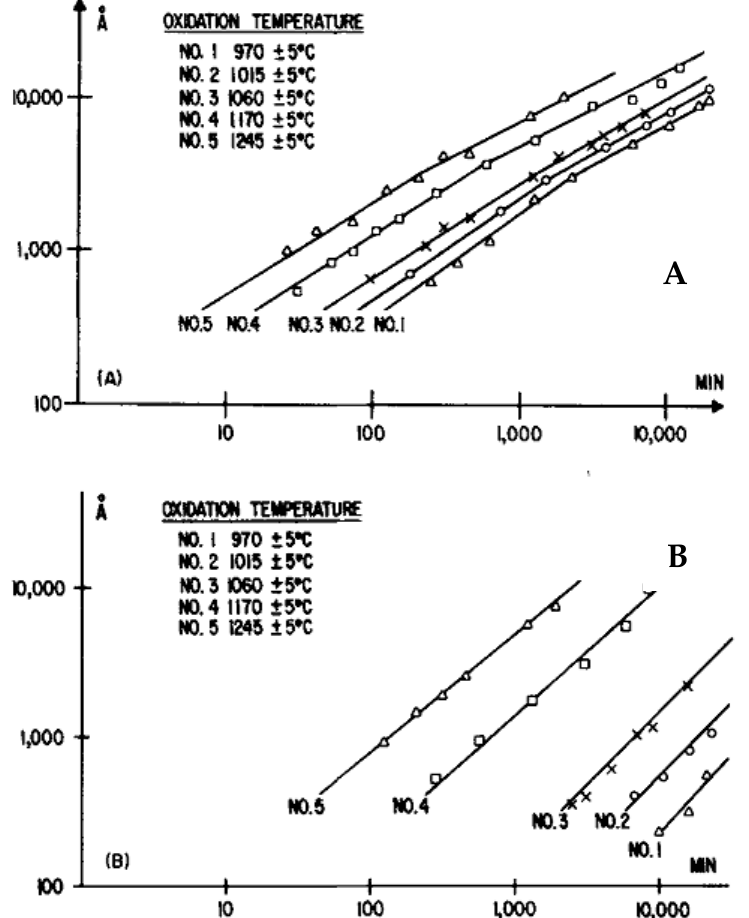
Figure 11. Oxide thickness vs. oxidation time on ( A ) thick oxide side and ( B ) thin oxide side. Reprinted with permission from Reference [12]. Copyright 1974 The American Ceramic Soci-